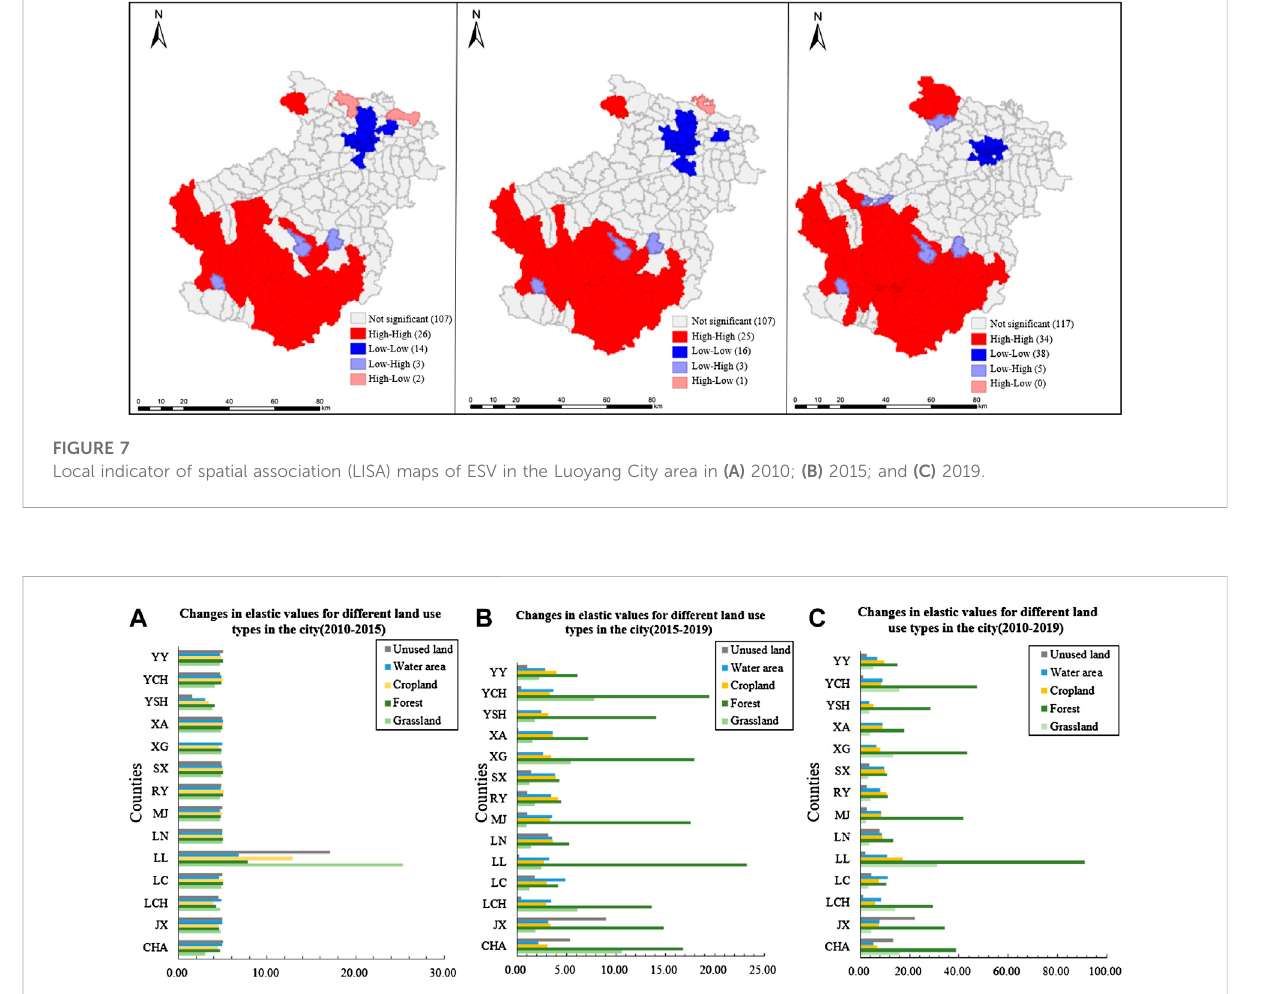
FIGURE 8 Changes in elastic values for different land-use types in the study area in (A) 2010 – 2015; (B) 2015-2019; (C)